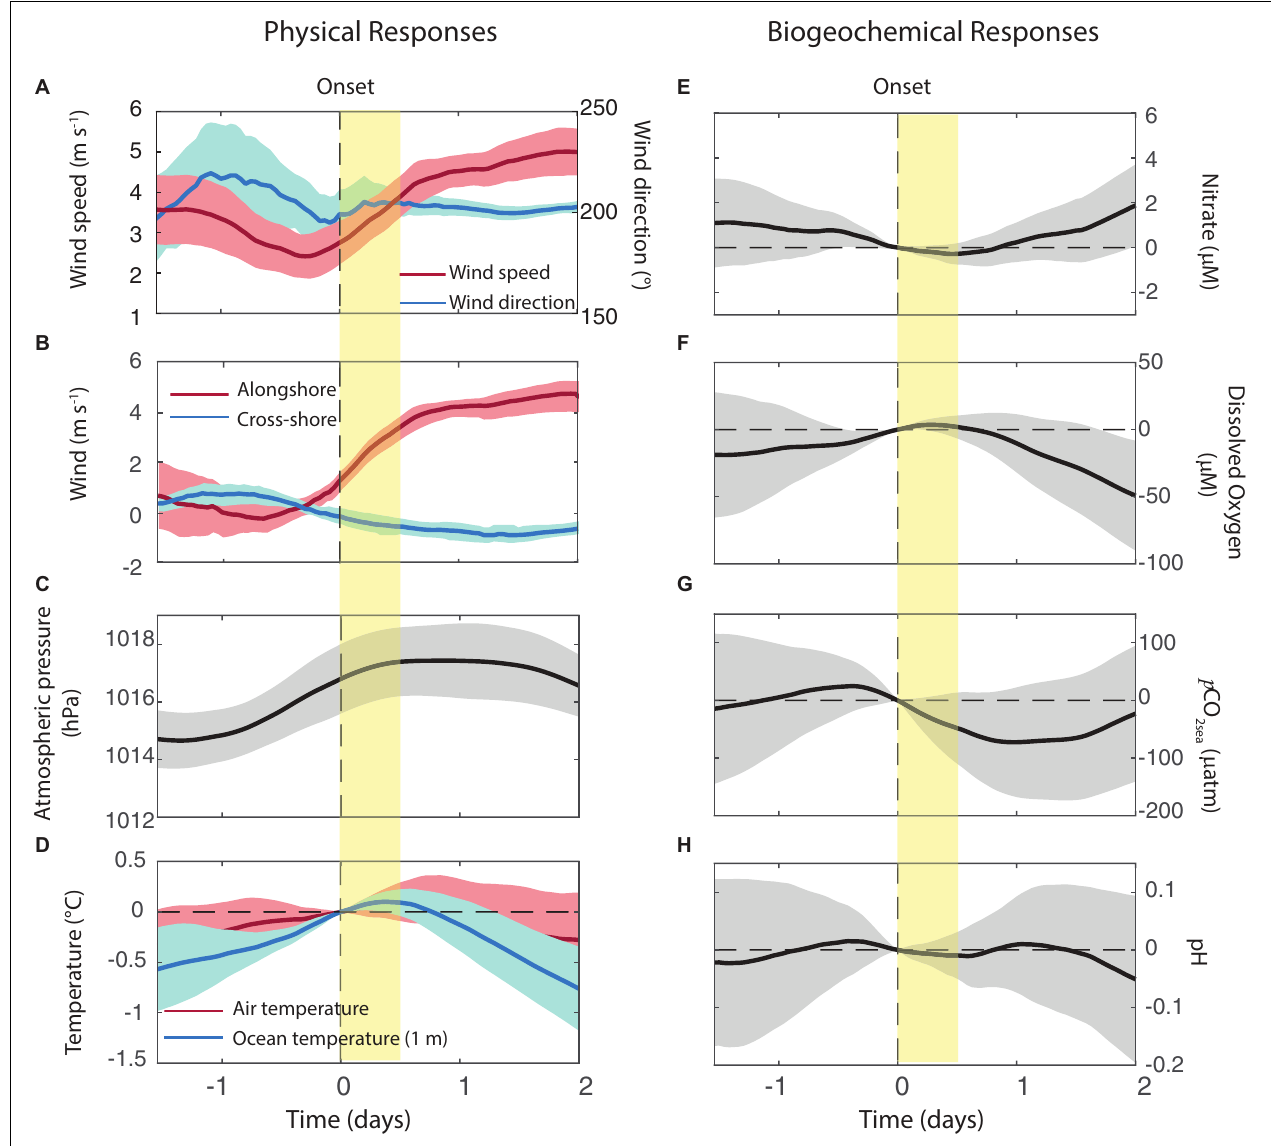
FIGURE 7 | Composite analysis of selected variables during the onset of the upwelling events. (A) Wind speed and direction, (B) Alongshore wind (red line) and cross-shore wind (blue line), (C) Sea level atmospheric pressure, (D) Air temperature (red line) and ocean temperature at 1 m depth (blue line), (E) Nitrate, (F) Dissolved Oxygen, (G) p CO 2 sea and (H) pH. Vertical yellow bars indicate 12 h after the onset of the upwelling